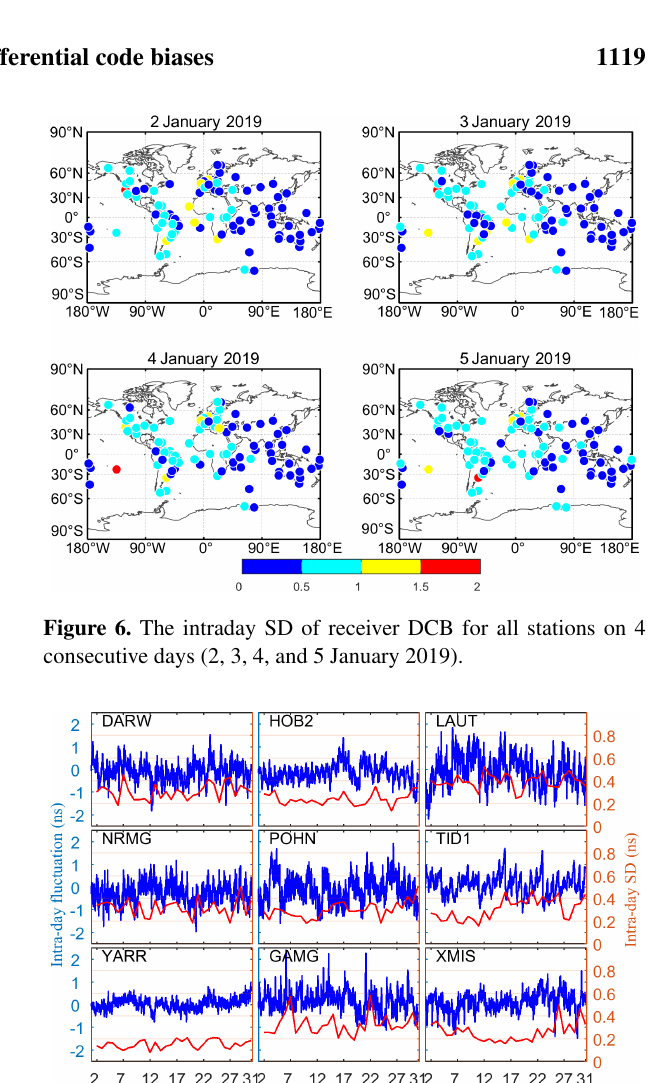
Figure 7. The intraday fluctuation (blue line) and intraday SD (red line) of the receiver DCB for the nine selected stations within